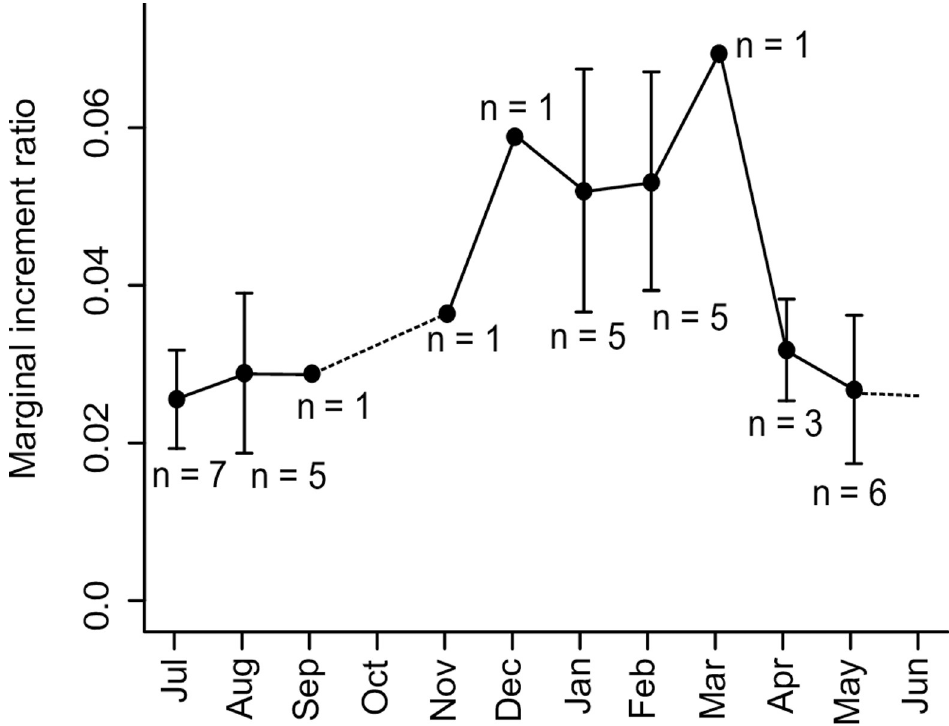
Fig 7. Monthly variation in the mean marginal increment ratio for Brachyhypopomus bennetti (n = 35). Here, marginal increment ratios were calculated by (R C -R L ) � (R L ) -1 where R C = the radius of the otolith and R L = the distance from the center of the otolith core to the center of a single dark annulus. Black dots and error bars represent the monthly mean +/- 1 standard deviation. Dotted lines connect months with missing intervening monthly means (See S5 Appendix for supporting